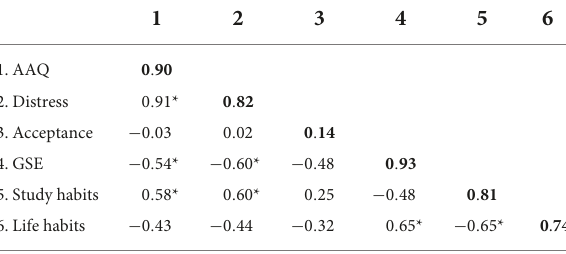
TABLE 3 Correlations of pre-program measures ( N =